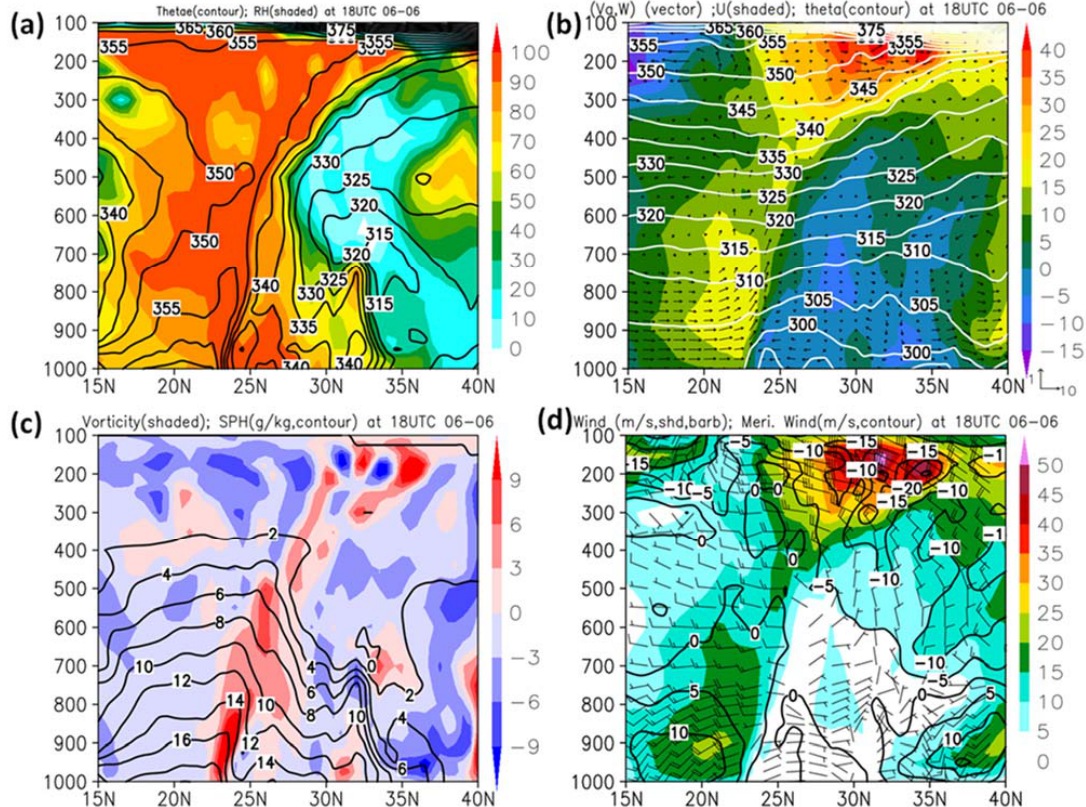
Figure 7. Vertical cross-section along 117 ◦ E at 1800 UTC 6 June (0200 LT 7 June). ( a ) Equivalent potential temperature (K, black lines) and relative humidity (%, shaded); ( b ) secondary circulation (vectors, vertical motion: Pa s − 1 ; ageostrophic winds: m s − 1 ), zonal winds ( u ) (m s − 1 , shaded), and potential temperature (K, solid lines); ( c ) specific humidity (g kg − 1 , solid line) and relative vorticity (s − 1 , shaded); and ( d ) horizontal winds ( V ; m s − 1 ) (full barb and half barb represent 10 and 5 m s − 1 , respectively), horizontal wind speed (m s − 1 , shaded), and meridional winds ( v ) (m s − 1 , contoured).